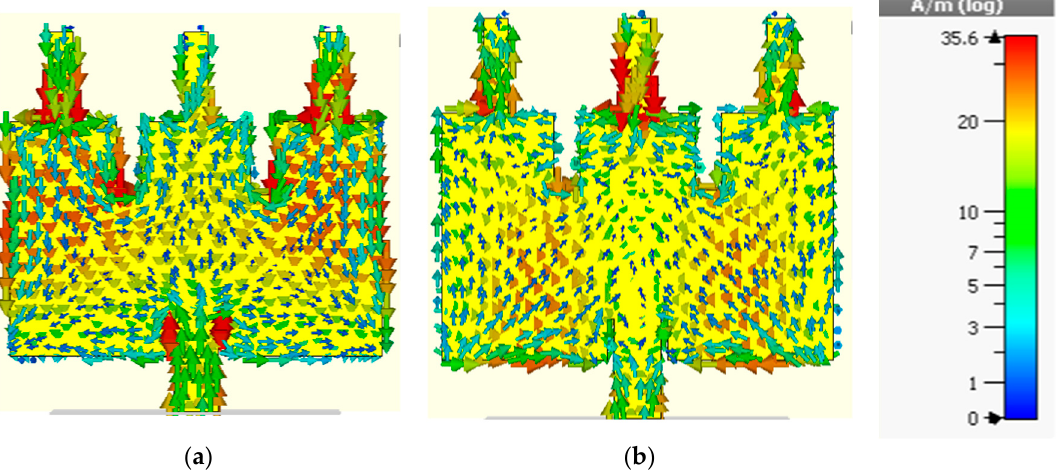
Figure 3. The current distribution of the antenna without DGS. ( a ) 3.736 GHz; ( b ) 6.0734 GHz.